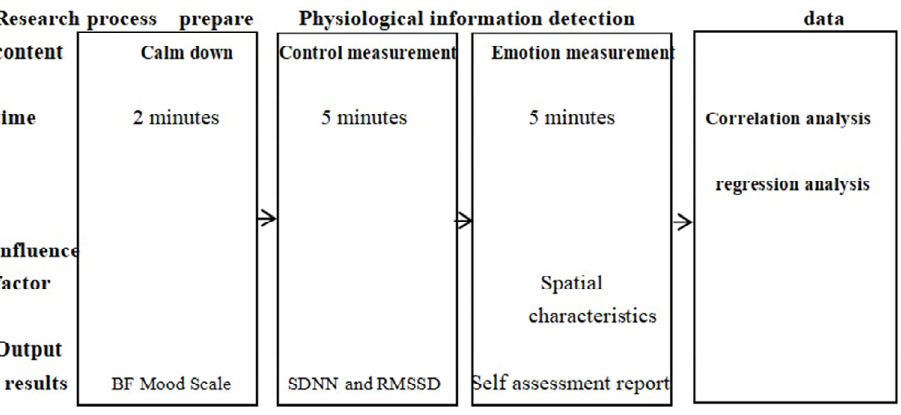
Figure 5. Experimental research process.